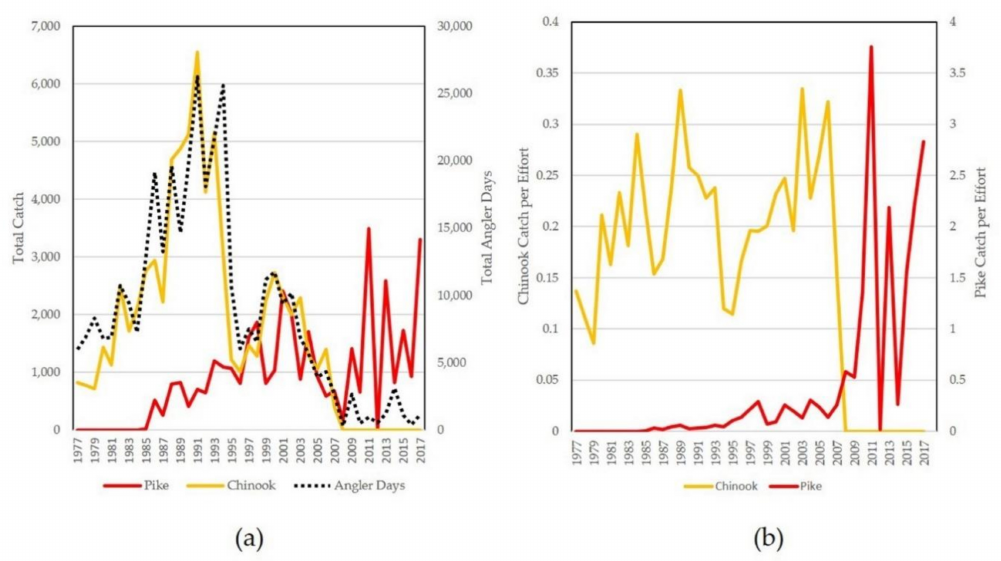
Figure 3. ( a ) Total angler catches of Chinook salmon and Pike in Alexander Creek (1977–2017) based on Statewide Harvest Survey estimates [47,49] and ( b ) Catch per angler e ff ort (angler day) for Chinook salmon and pike in Alexander Creek (1977–2017). Note: Sport fishing for Chinook Salmon was closed in 2008 due to their low returns (Figure